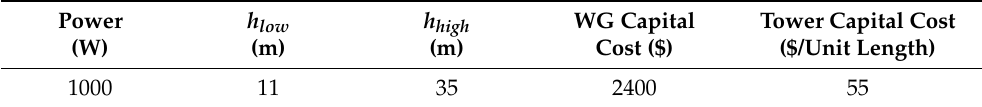
Table 1. Specification of the WG.